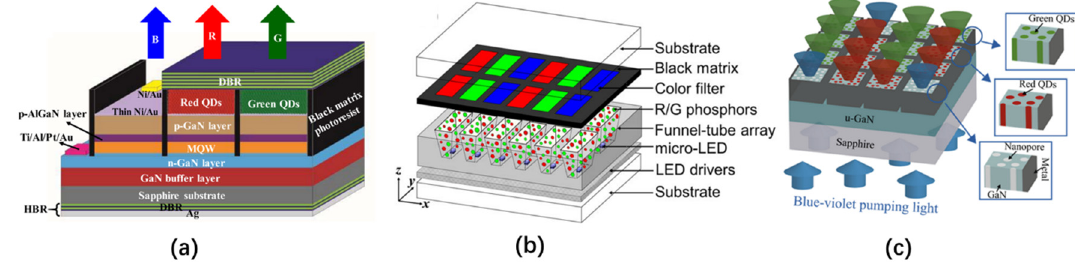
Figure 12. ( a ) Monolithic RGB QD micro-LED with a black matrix photoresist spacer, hybrid Bragg reflector (HBR) and DBR structure. Reproduced from [82], with permission from Institute of Electrical and Electronics Engineers, 2018; ( b ) RGB QD micro-LED with a funnel tube array structure. Reproduced from [84], with permission from John Wiley and Sons, 2019; ( c ) GaN nanoporous (NP) structure conversion layer preparation process. Reprinted with permission from [85]. Copyright (2020) American Chemical Society.